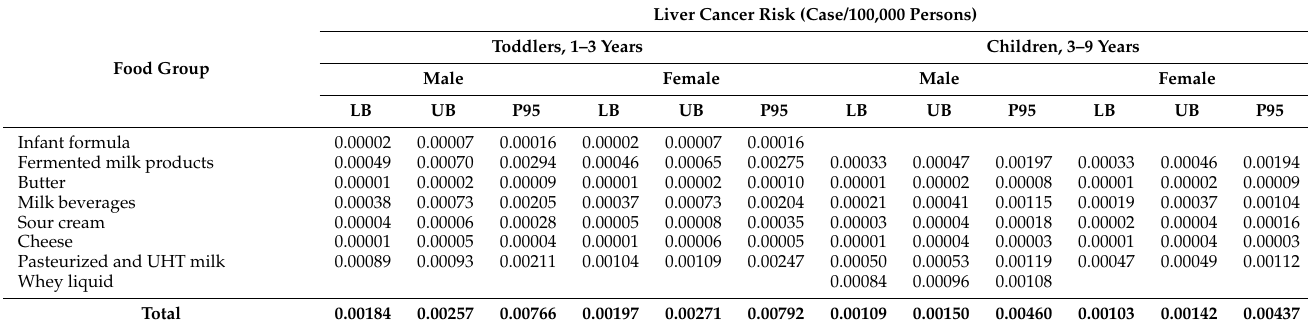
Table 7. Cancer risk estimates calculated from the chronic dietary exposure to AFM1. Scenario 2 (95% upper bound (UB)).